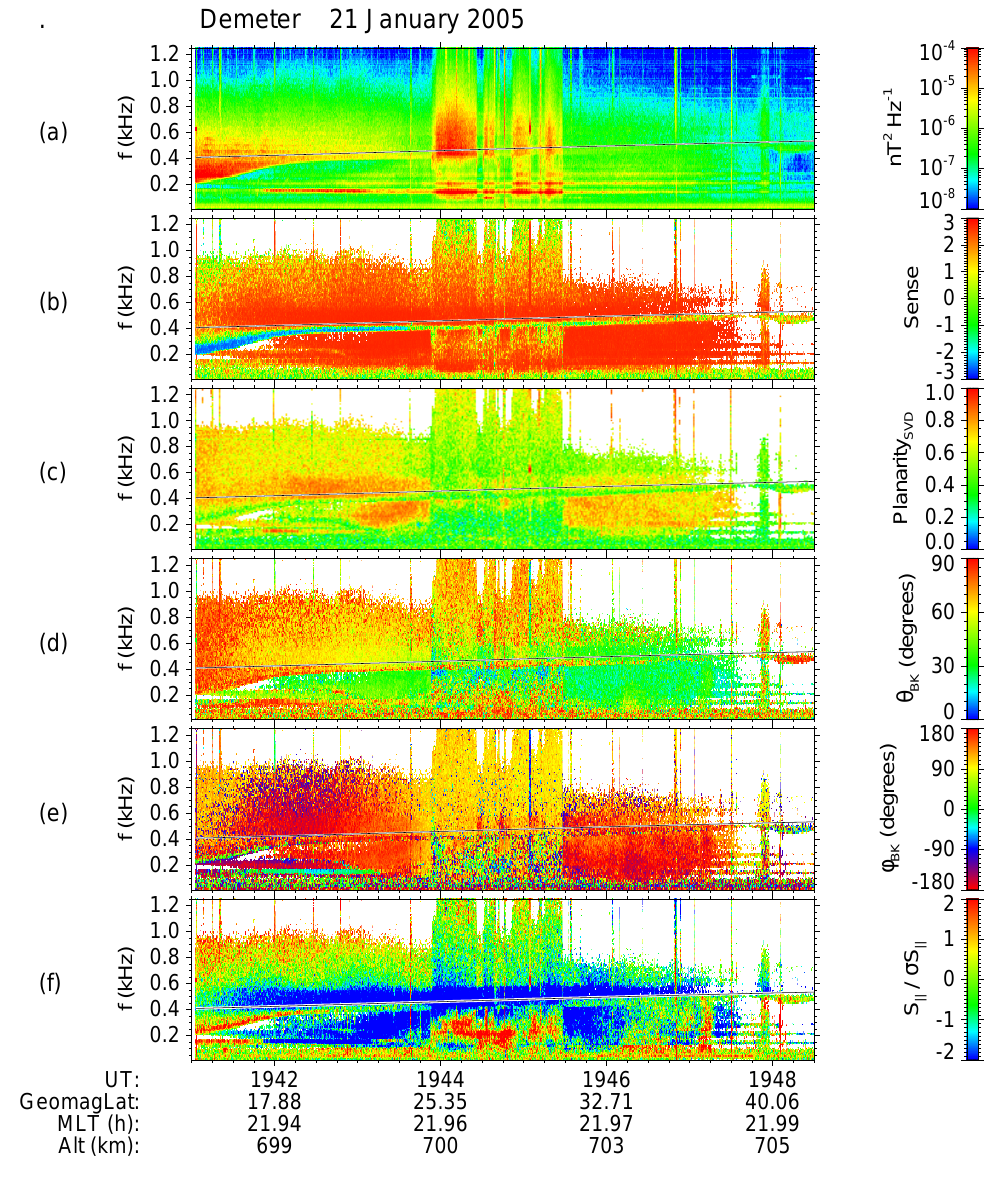
Fig. 10. Same presentation as in Fig. 9 but for the event